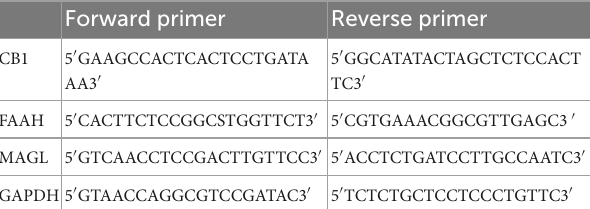
TABLE 1 Primers pairs sequences used in